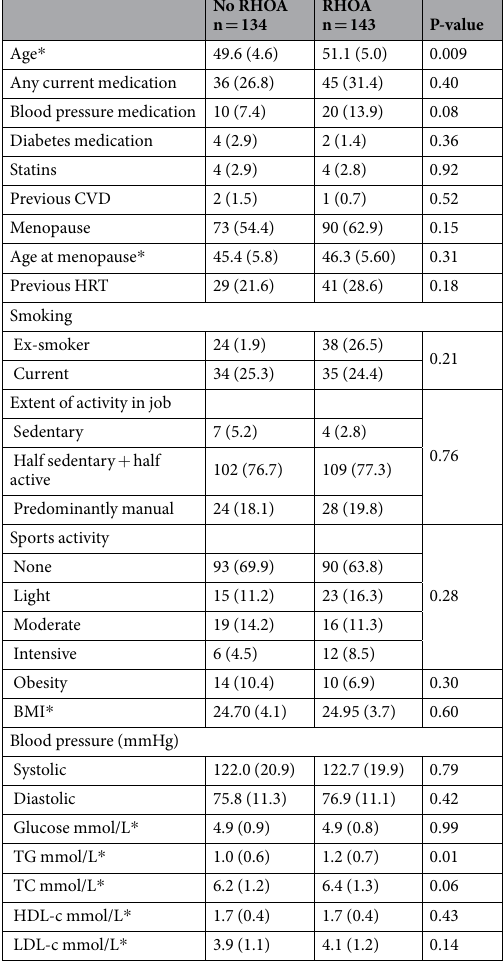
Table 2. Baseline characteristics of study population according to incident radiographic hand osteoarthritis (RHOA) at 11 years of follow-up. Numbers are percentages unless otherwise stated. * Mean (standard deviation) CVD: cardiovascular disease; HRT: hormone replacement therapy, BMI: body mass index; TG: triglycerides, TC: total cholesterol, HDL-c: high-density lipoprotein cholesterol, LDL-c: low-density lipoprotein